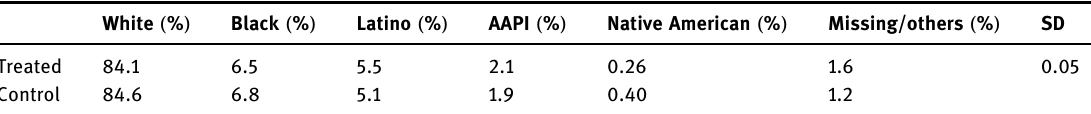
Table A5: Standardized di ff erences ( SD ) between treated and control populations in RCT gold dataset, for the measured ethnicity variable